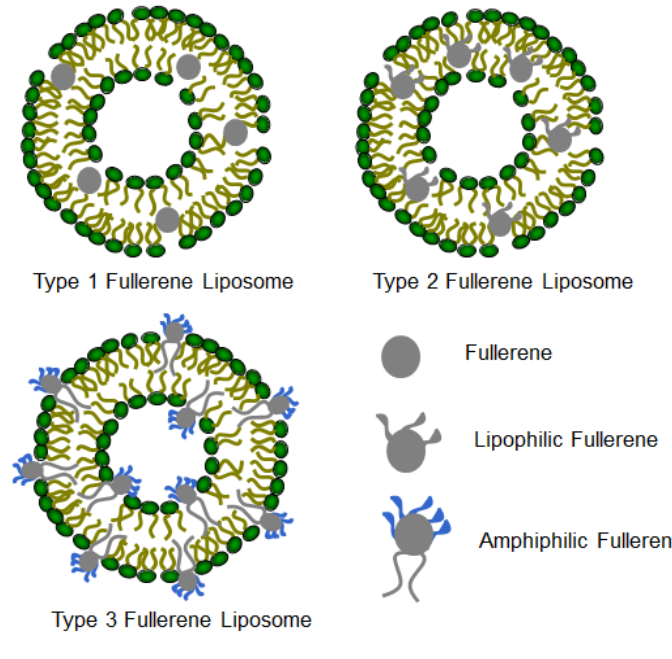
Figure 2. Three types of fullerene liposomes incorporating un-derivatized fullerenes, lipophilic fullerenes and amphiphilic fullerenes,